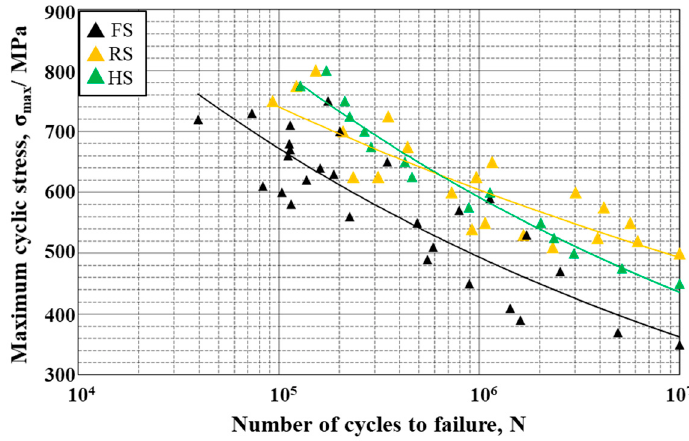
Figure 3. S-N curves of Ti64 samples subjected to different thermo-mechanical processing.